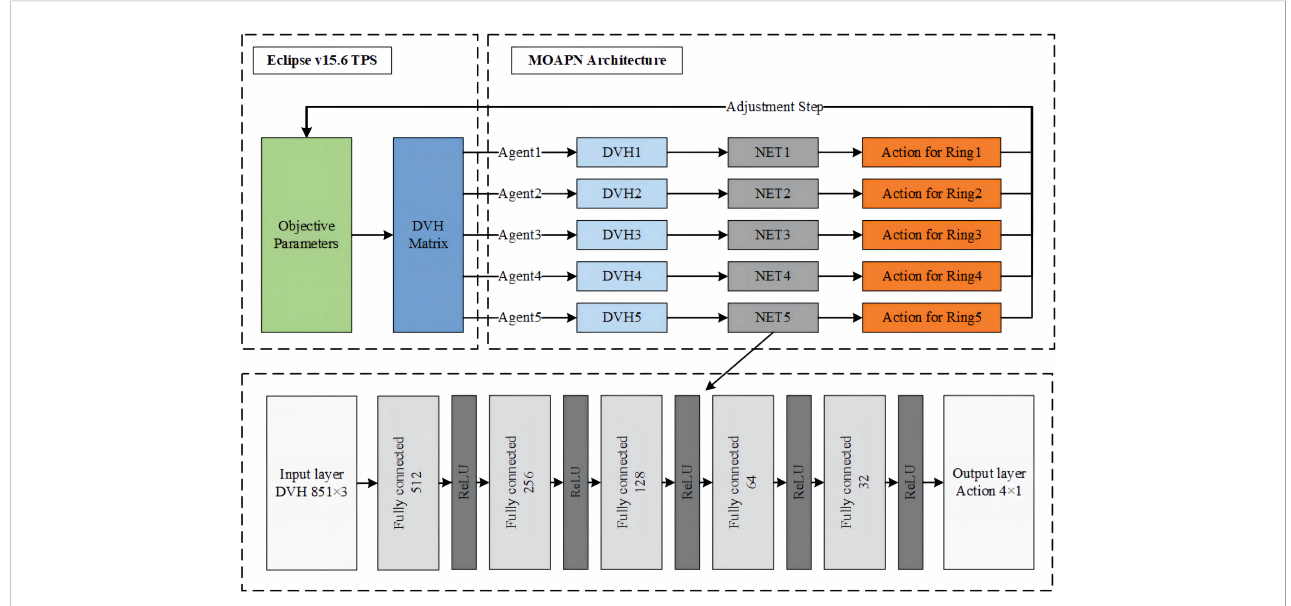
FIGURE 2 The network architecture of the